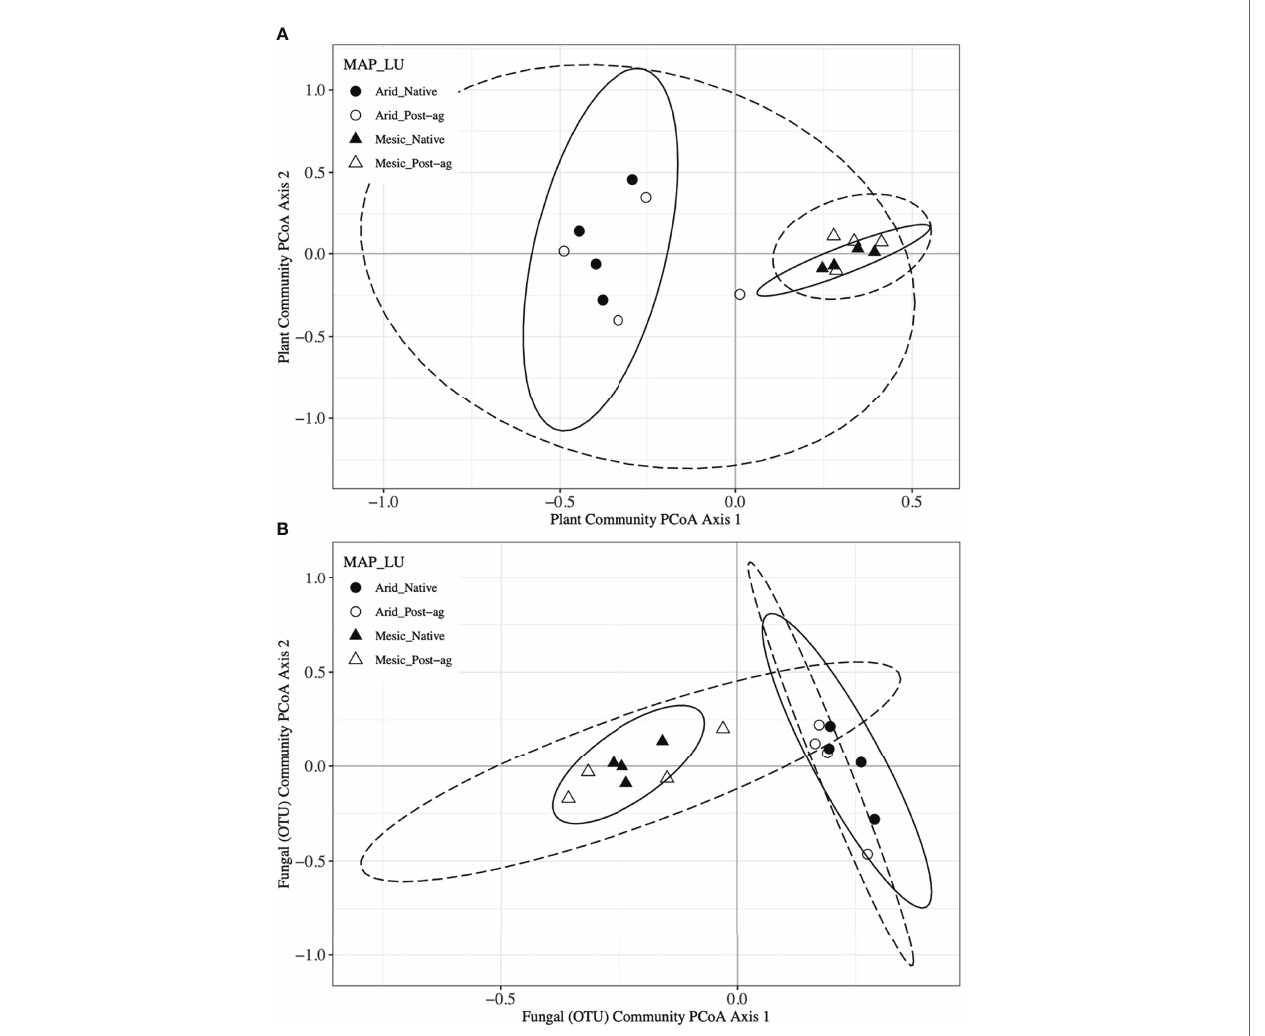
FIGURE 4 | Principal Coordinates Analyses (PCoA) of plant (A) and fungal community composition using Operational Taxonomic Units (OTUs) (B) in native prairie remnants (solid line and fi lled symbols) and post-agricultural sites (dashed line and open symbols). Circles indicate the arid end of the precipitation gradient (455.7 – 634.9 mm yr -1 ), whereas triangles indicate the mesic end (760.9 – 1040.5 mm yr -1 ). Lines indicate the 95% con fi dence intervals around PCoA centroid for each group in the PCoA